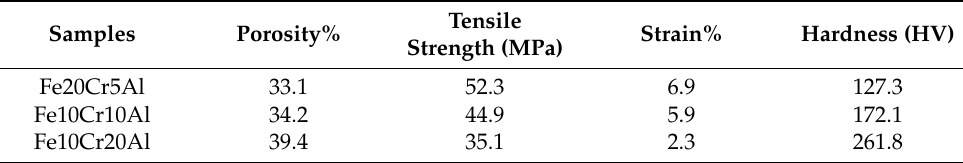
Table 2. Properties of the synthesized porous materials.